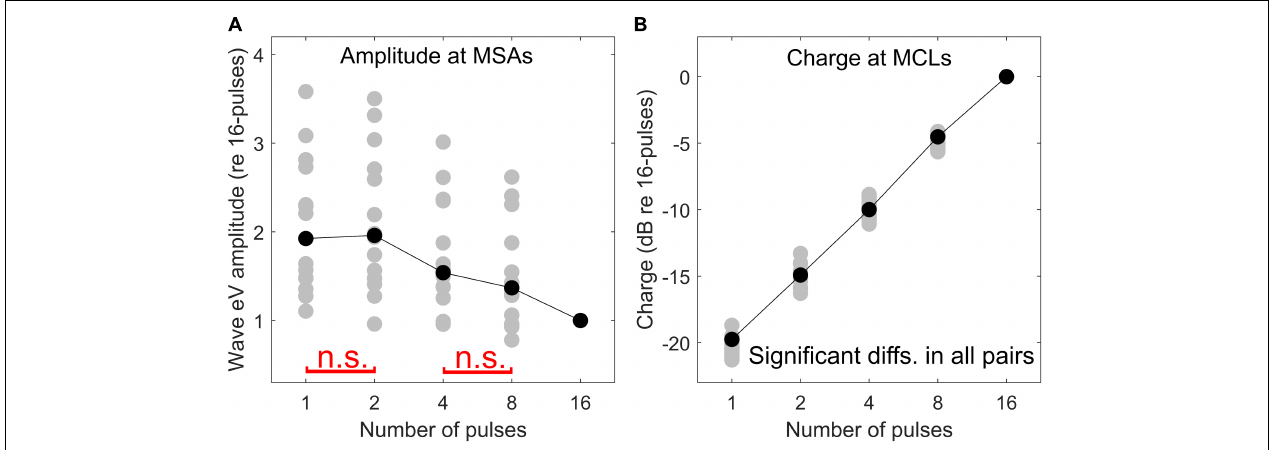
FIGURE 13 | Comparison of psychophysical and eABR results. eABR wave eV amplitude at MSAs (95% of psychophysical MCLs) (A) and corresponding stimulation TBCs led to psychophysical MCLs (B) . All data are normalized to their corresponding values at the 16-pulse condition. The “n.s.” in red in panel (A) shows not significant differences between 1 pulse and 2 pulses and between 4 pulses and 8 pulses. The difference between the rest of the pairs was significant. In panel (B) , all pairs were significantly